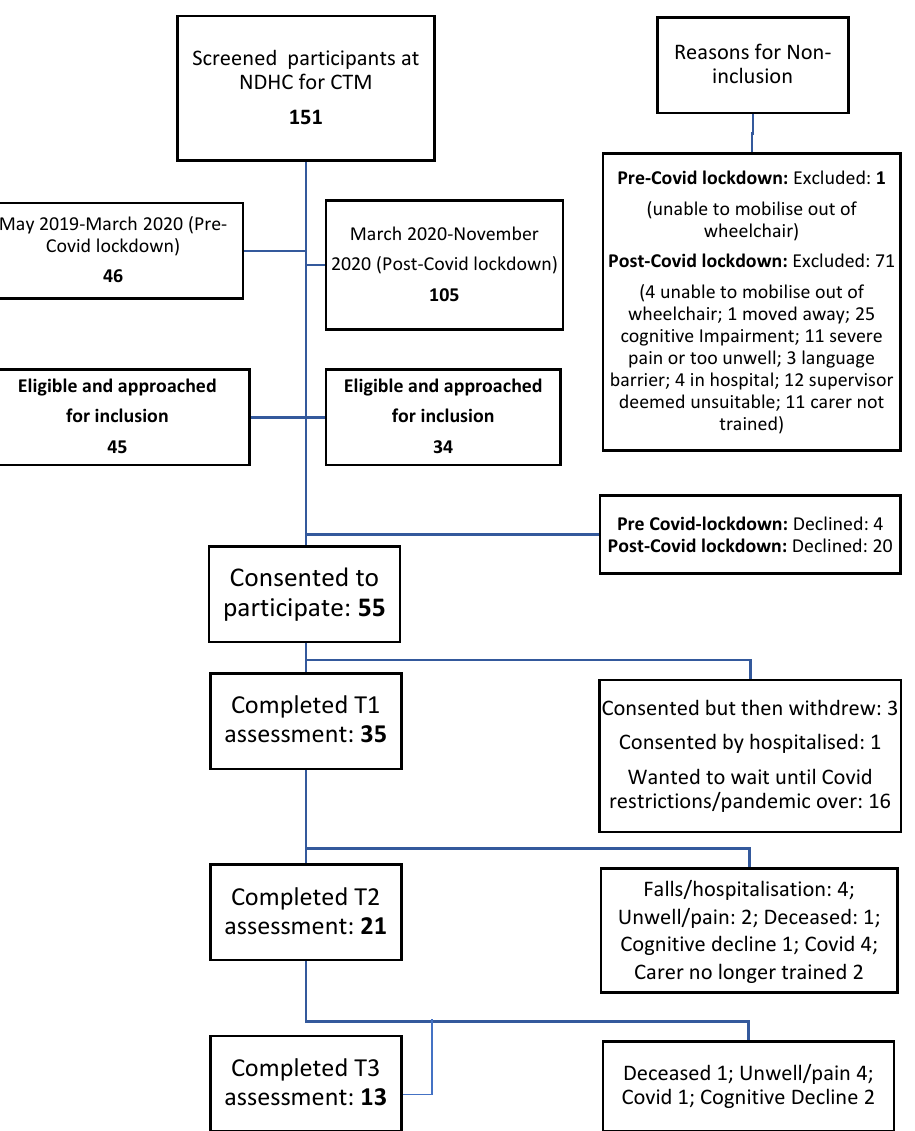
Figure 1. Flow of the participants in the CTM feasibility study (before and after COVID-19 social distancing